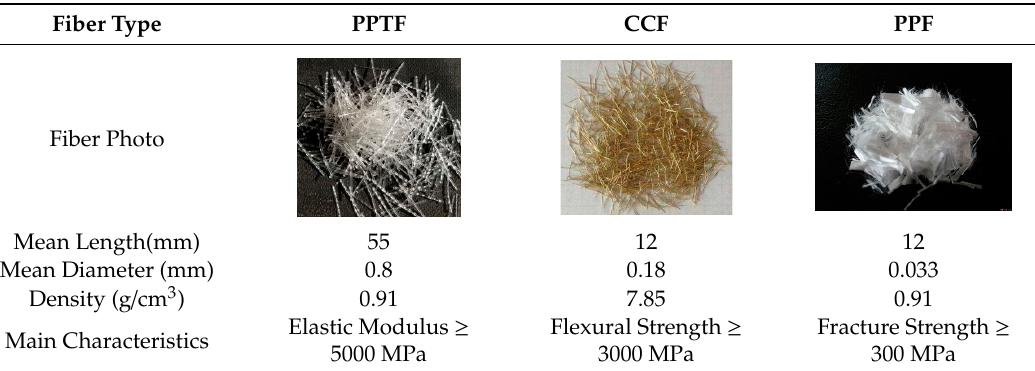
Table 3. Photos and characteristics of fibers.